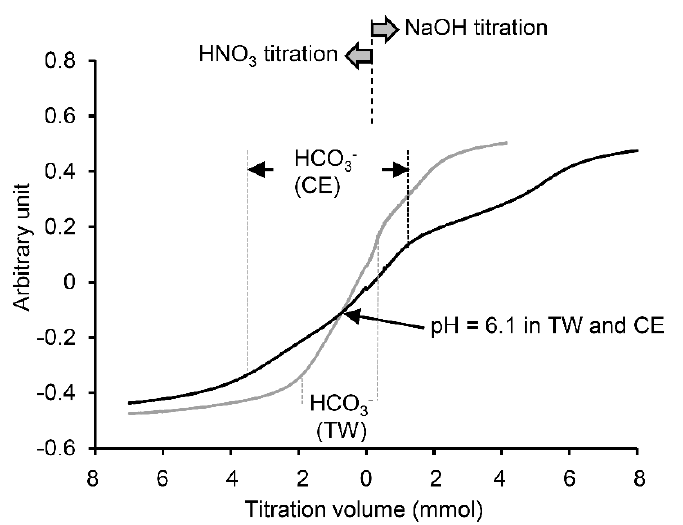
Figure 3. An original recording of urine titration curve for a typical single subject in the tap water (TW; gray line) and carbohydrate solution (CE+HCO 3 ; black line) group, respectively. White circles indicate the breaking points for each titration curve and a gray circle indicates pH = 6.1.